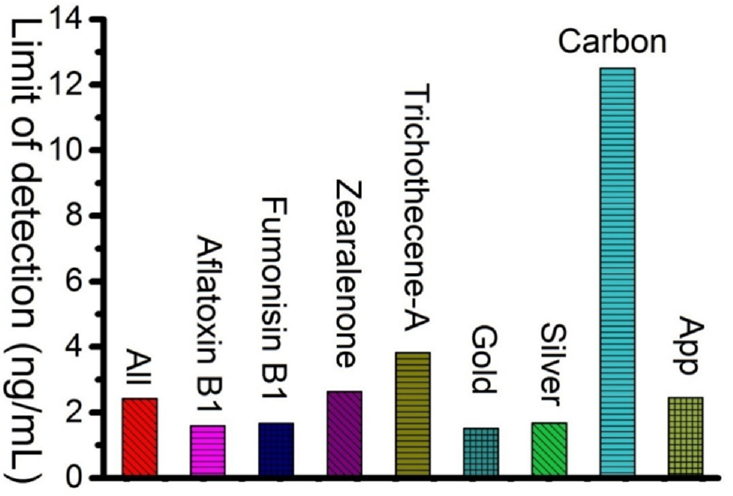
Figure 5. Average limits of detection of strips of different types of mycotoxins. Since there are missing values in the datasets of particle size and replications, My- cotoxin, Nanoparticle, and Phone were analyzed by three-way ANOVA. From these three variables, only one variable (Nanoparticle) significantly contributes to the outcome ( p = 1.75 × 10 − 7 ). The ANOVA results with a non-parametric technique (Kruskal–Wallis rank sum test) and Dunn’s test (post-hoc) indicate that the significant difference is between the Nanoparticle groups, gold and silver. The ANOVA results with a non-parametric tech- nique (Kruskal–Wallis rank sum test) and Dunn’s test (post-hoc) indicate that the significant difference is between the gold Nanoparticle groups and the no gold Nanoparticle groups. There is no significant statistical difference between the LOD as read by a mobile phone or otherwise ( p = 0.153). Multivariate linear regression was performed to explore the relationship between the LOD and the parameters of type of mycotoxin, type of nanoparticle, particle size, year of publication, and replication. The linear regression had an R 2 = 0.866, particle size on predic- tion of the LOD (R 2 = 0.904), and particle type on prediction of the LOD (R 2 = 0.901). The resultant prediction equation is: LOD = 783.5 − 1.218 × Mycotoxin + 5.018 × Nanoparticle type + 0.0007274 × Particle size − 0.3875 × Year − 0.6992 × Replicates. Nanoparticle size is the strongest predictor ( p < 0.0001, R 2 = 0.904), followed by Particle type and